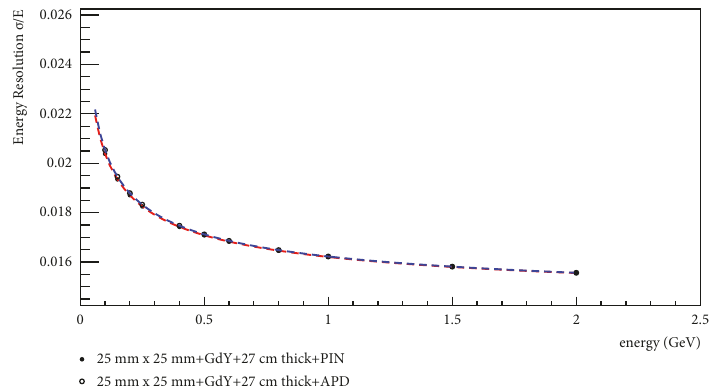
Figure 6: Parameterized energy resolution function (dashed lines) and energy resolution values at certain energies (points) for scintillator- photodetector combinations belonging to GdY with 25 mm x 25 mm back face area of each scintillator and 27 cm thickness.